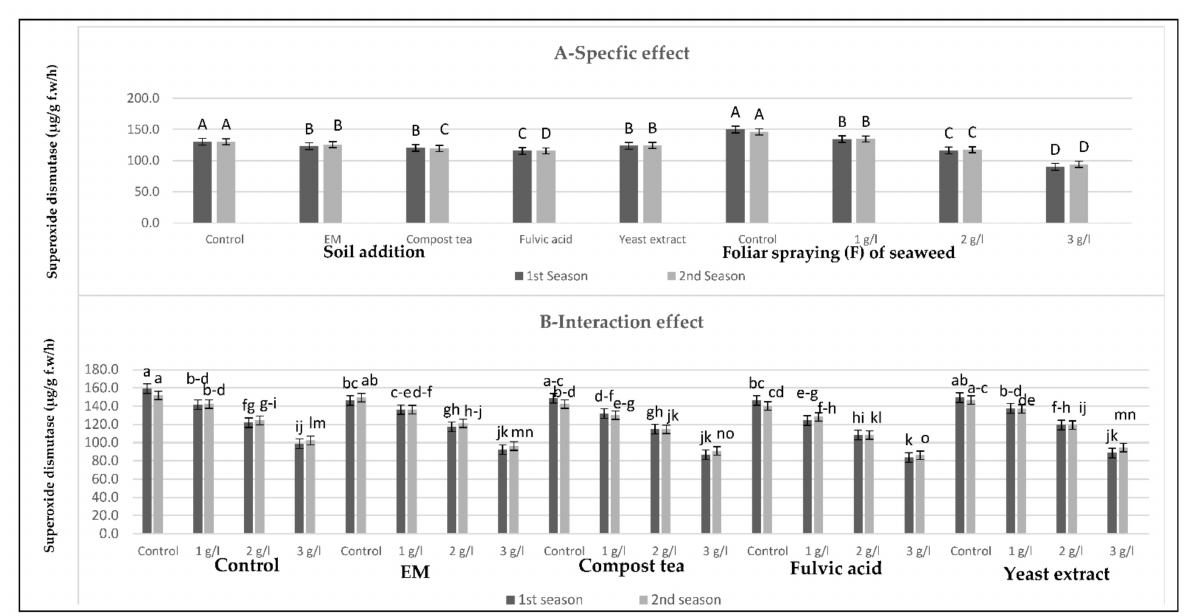
Figure 7. ( A , B ) Effects of soil addition of EM, compost tea, fulvic acid, yeast extract, and foliar spray with seaweed extract on the superoxide dismutase ( µ g/g f.w/h) of sweet pepper plants during the 2019/2020 and 2020/2021 seasons. Specific effects are indicated with uppercase letters and the interactions are indicated with lowercase letters, unless otherwise mentioned, according to Tukey’s multiple range test (TMRT) at p ≤